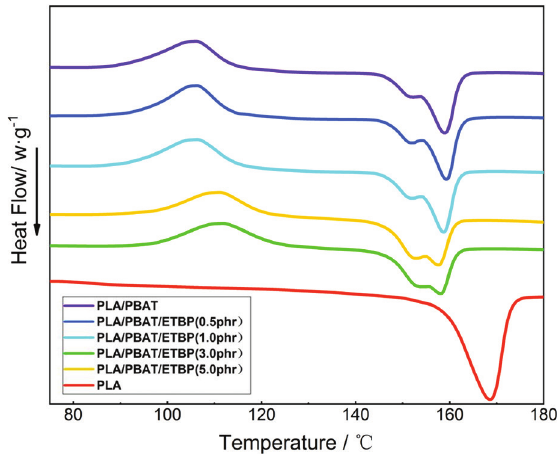
Figure 6: DSC curve of the PLA/PBAT blends with different content of ETBP by first heating cycle.